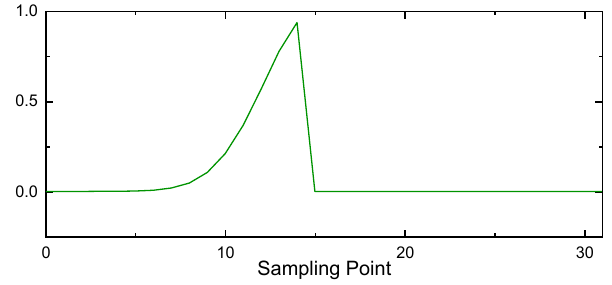
Figure 5. Data impact diagram.